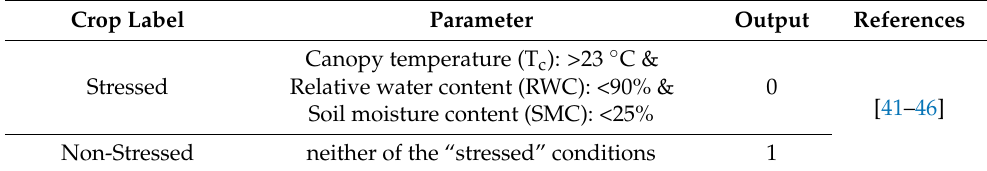
Table 3. Crop and auxiliary data ranges for stressed and non-stressed labeling. Crop Label